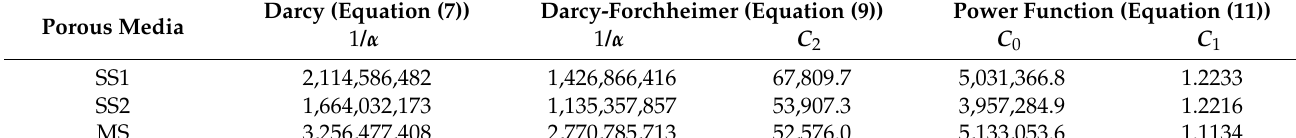
Table 2. Values of the inverse of the permeability α , inertial resistance factor C 2 , and power function coefficients C 0 and C 1 fitted with experimental data for Darcy, Darcy-Forchheimer and power function equations.